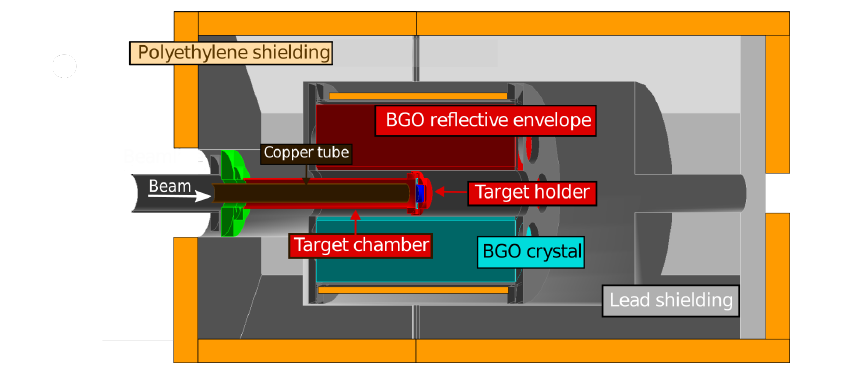
Figure 1. Section of the 3D model of the present experimental setup, which was used in the Geant4 simulation.